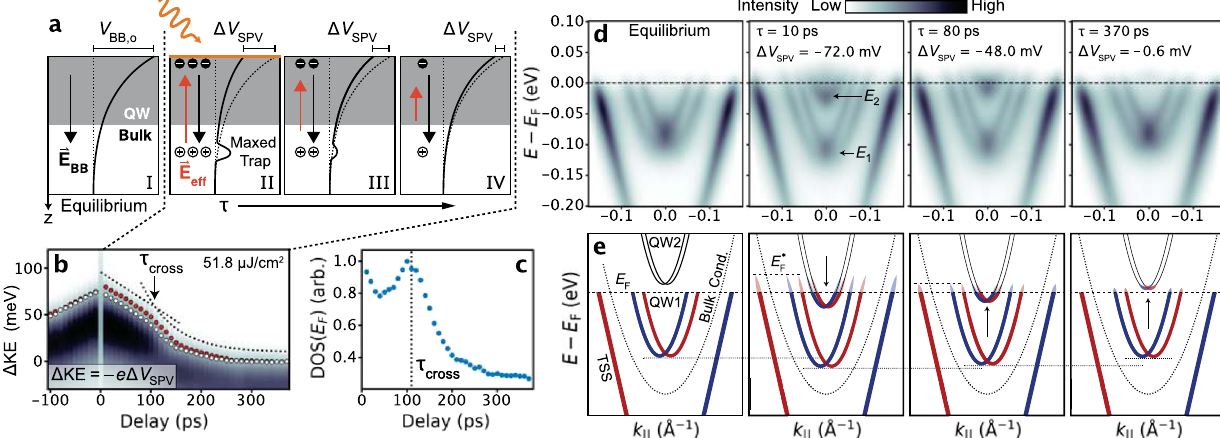
Fig. 2 Time-resolved electric fi eld gating of quantum well spectrum. a Effective applied fi eld, E eff is generated by separated photoexcited carriers, manifesting as a reduction of the band-bending potential. SPV is maximized before quenching the band-bending due to a fi nite limit on trapped holes. As photoexcited charge recombines, band-bending returns, and the effective fi eld is reduced. b Separated surface charge can be monitored by the rigid energy shift of the ARPES spectrum due to the voltage change at the surface ( Δ V SPV ). Black-lined white dots correspond to the SPV-induced rigid shift of the band structure relative to equilibrium E F , red dots correspond to the quasi-Fermi level at k F of the TSS. c DOS at the Fermi level as a function of delay revealing the Lifshitz transition of QW2. d Symmetrized ARPES spectra at equilibrium and three non-equilibrium delays demonstrating the pump-induced quantum well shifts after correcting the SPV shift. e Graphic summarizing quantum well spectrum dynamics corresponding to the spectra in d , presenting a delay-dependent fi eld effect on the quantum wells and long-lived quasi- E F